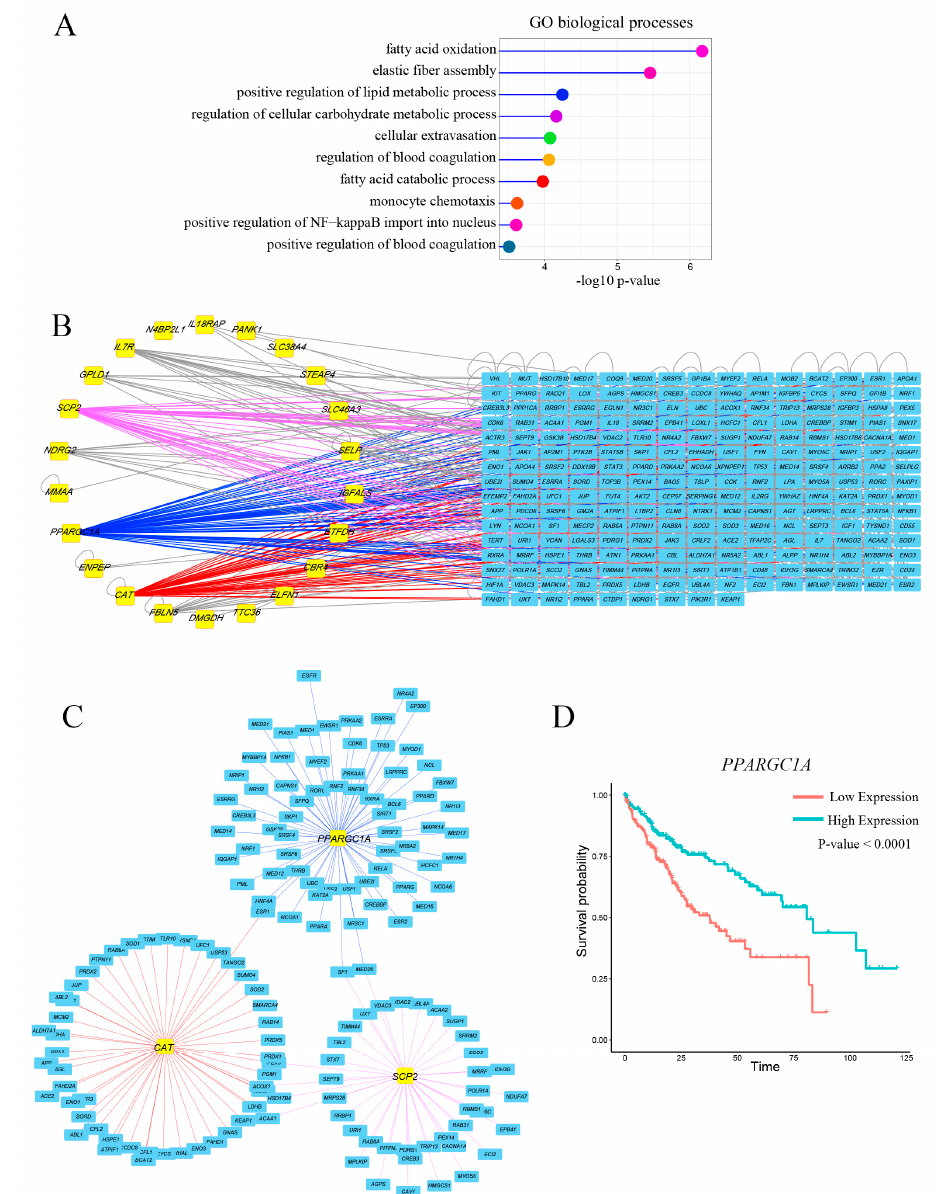
Figure 2. Hub gene PPARGC1A was associated with LIHC patient prognosis. ( A ) GO enrichment for the five DEMs matched genes. y -axis represents GO terms and x -axis represents fold enrichment (with − log10 p -value); ( B ) The interaction network of 22 DEGs which have significant effects on patient survival. Yellow boxes: DEGs; blue boxes: reported gene in human; ( C ) Subnetwork of three hub nodes including gene PPARGC1A , CAT , and SCP2 ; ( D ) Gene PPARGC1A was able to significantly distinguish the overall survival of LIHC patients. PPARGC1A: Peroxisome proliferator-activated receptor gamma coactivator-1 alpha; GO: Gene Ontology; CAT: Catalase; SCP2: Sterol carrier protein 2.